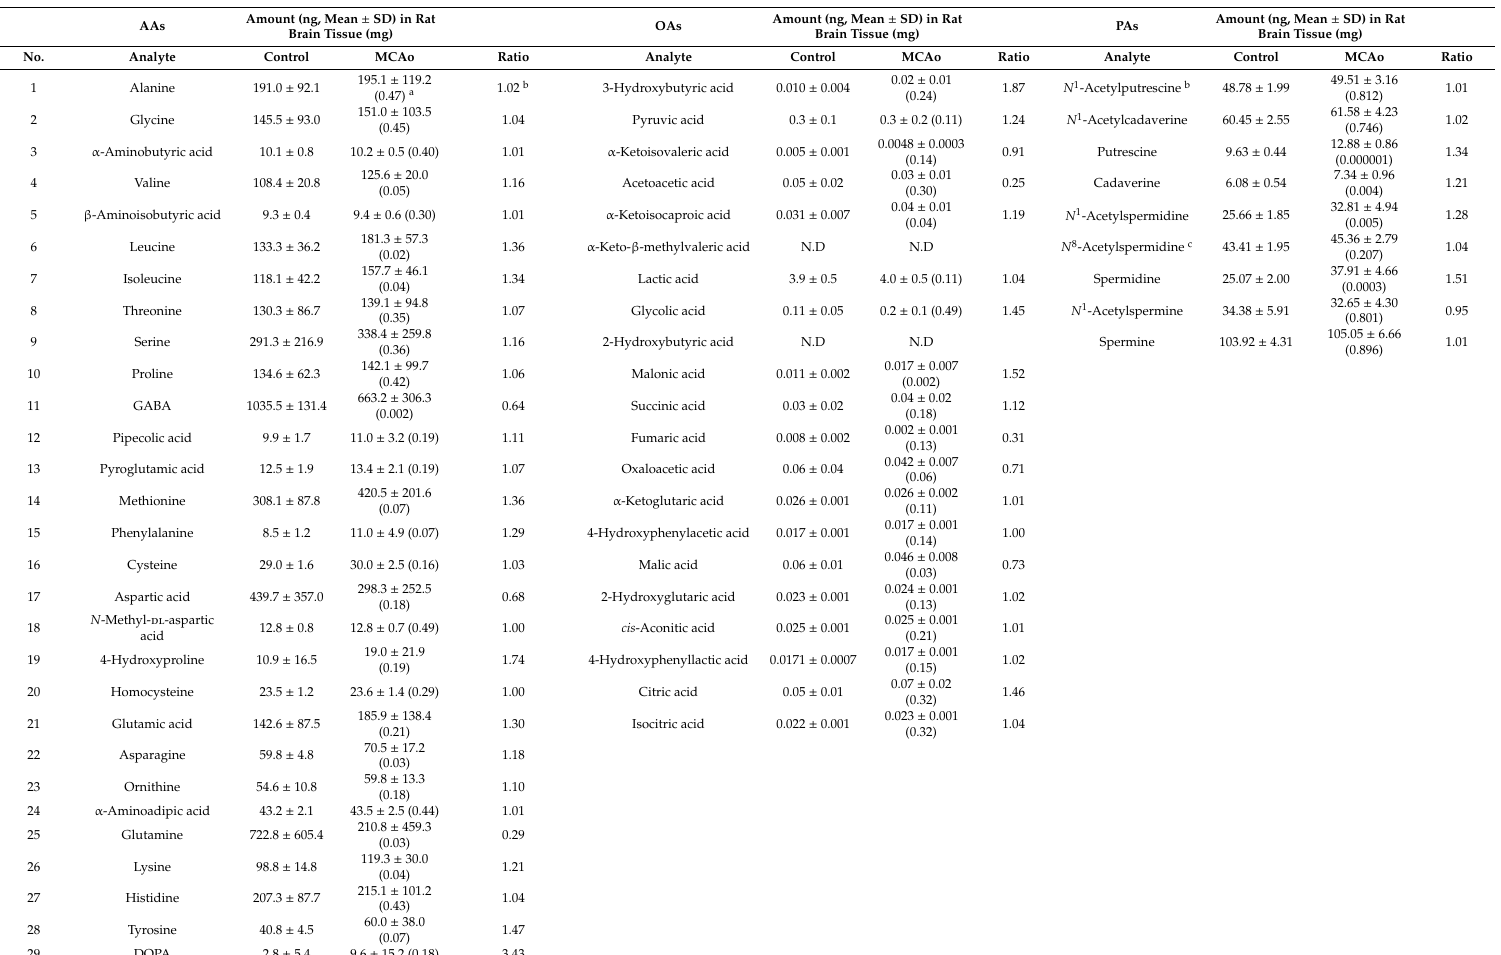
3.43 a Student t-test comparing the mean values of the MCAo group with those of the control group. b Ratio of analyte levels in MCAo group to corresponding mean values in the control group. N.D: Not detected. PAs data is reproduced from our pervious study, Copyright © 2016 [65]. b N 1 -Acetyl: Acetylation at N1-position of chemical. c N 8 -Acetylspermidine: Acetylation